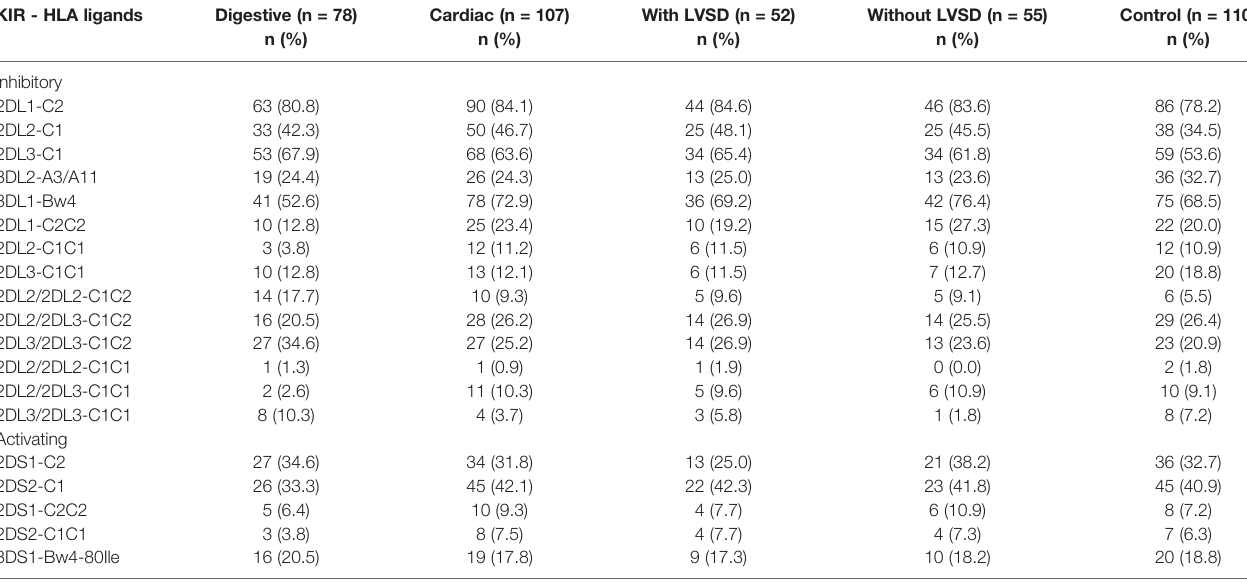
TABLE 5 | Distribution of KIR and their respective HLA ligands in patients with the digestive or cardiac forms of chronic Chagas disease, in patients with LVSD and without LVSD and in control individuals. KIR - HLA ligands